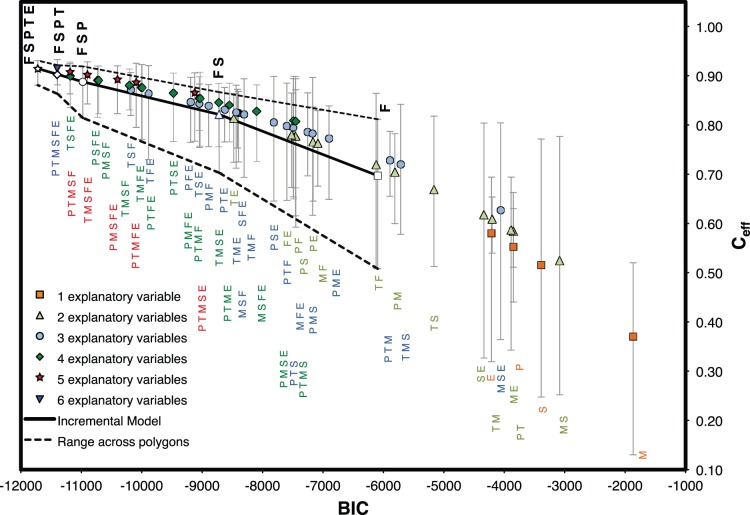
Incremental improvement of model III performance with the addition of the explanatory variables.Variables are precipitation, P; mean temperature, T; maximum temperature, M; soil moisture, S; fire, F; and potential evapotranspiration, E. Best models are shown in bold with white symbols (F, FS, FSP, FSPT, FSPTE), solid lines show weighted averages and dashed lines the range across the spatial domain (Ceff: Nash-Sutcliffe Coefficient; BIC: Bayesian Information Criterion).